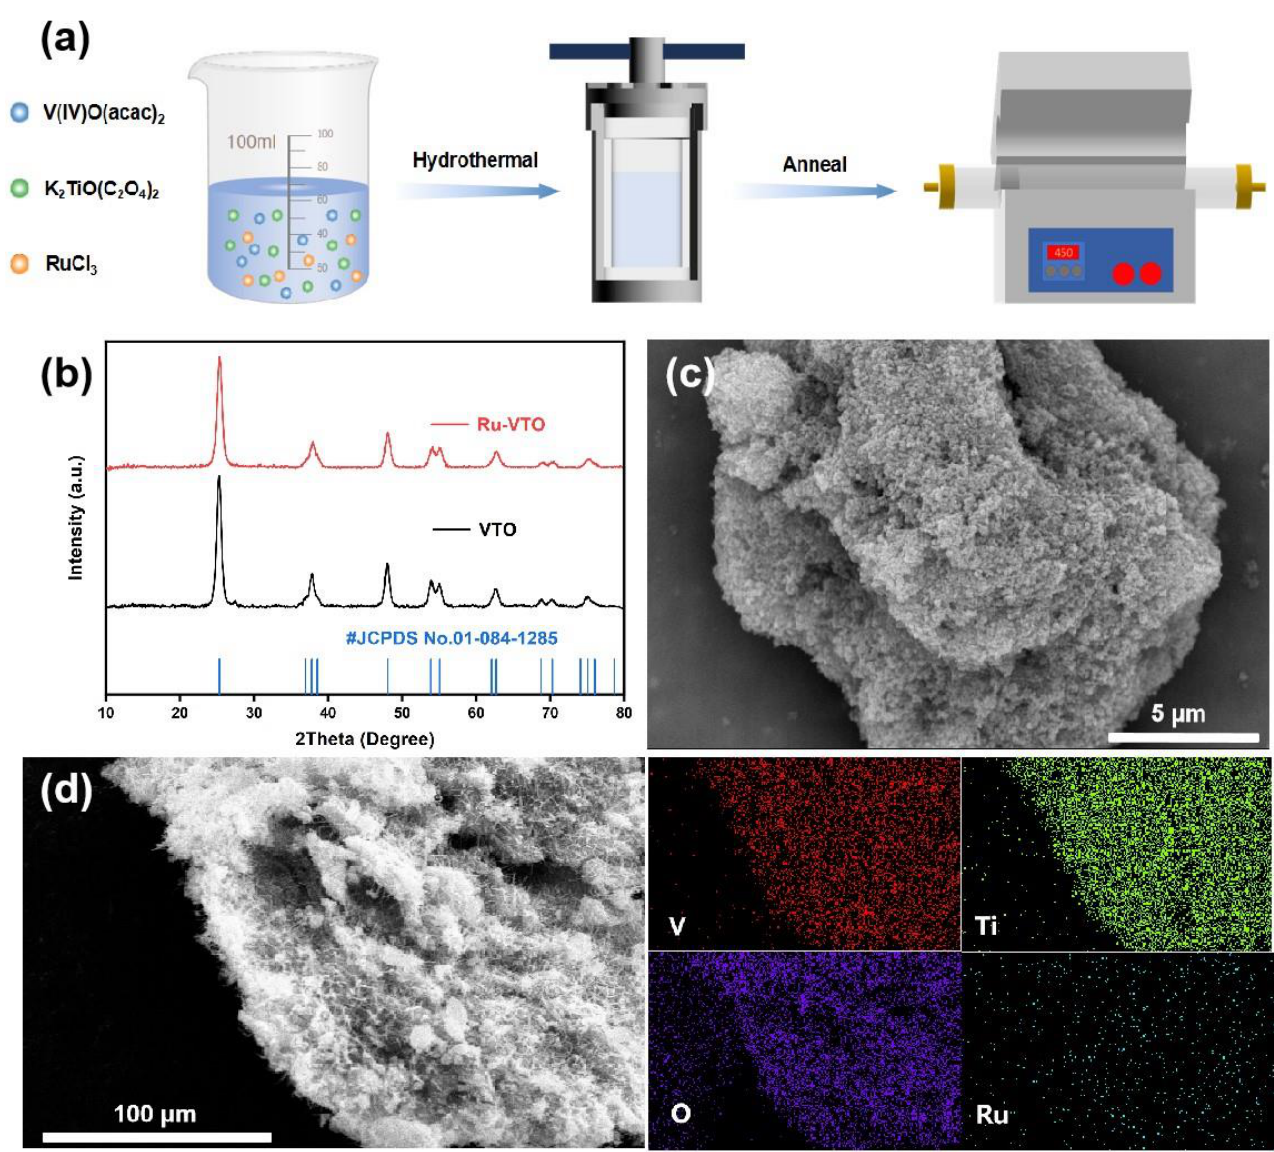
Figure 1. ( a ) Schematic illustration of the typical synthetic process of Ru-VTO. ( b ) XRD comparison of Ru-VTO and VTO. ( c ) Scanning electron microscopy (SEM) images of Ru-VTO. ( d ) Large-scale area EDS-mapping of Ru-VTO.